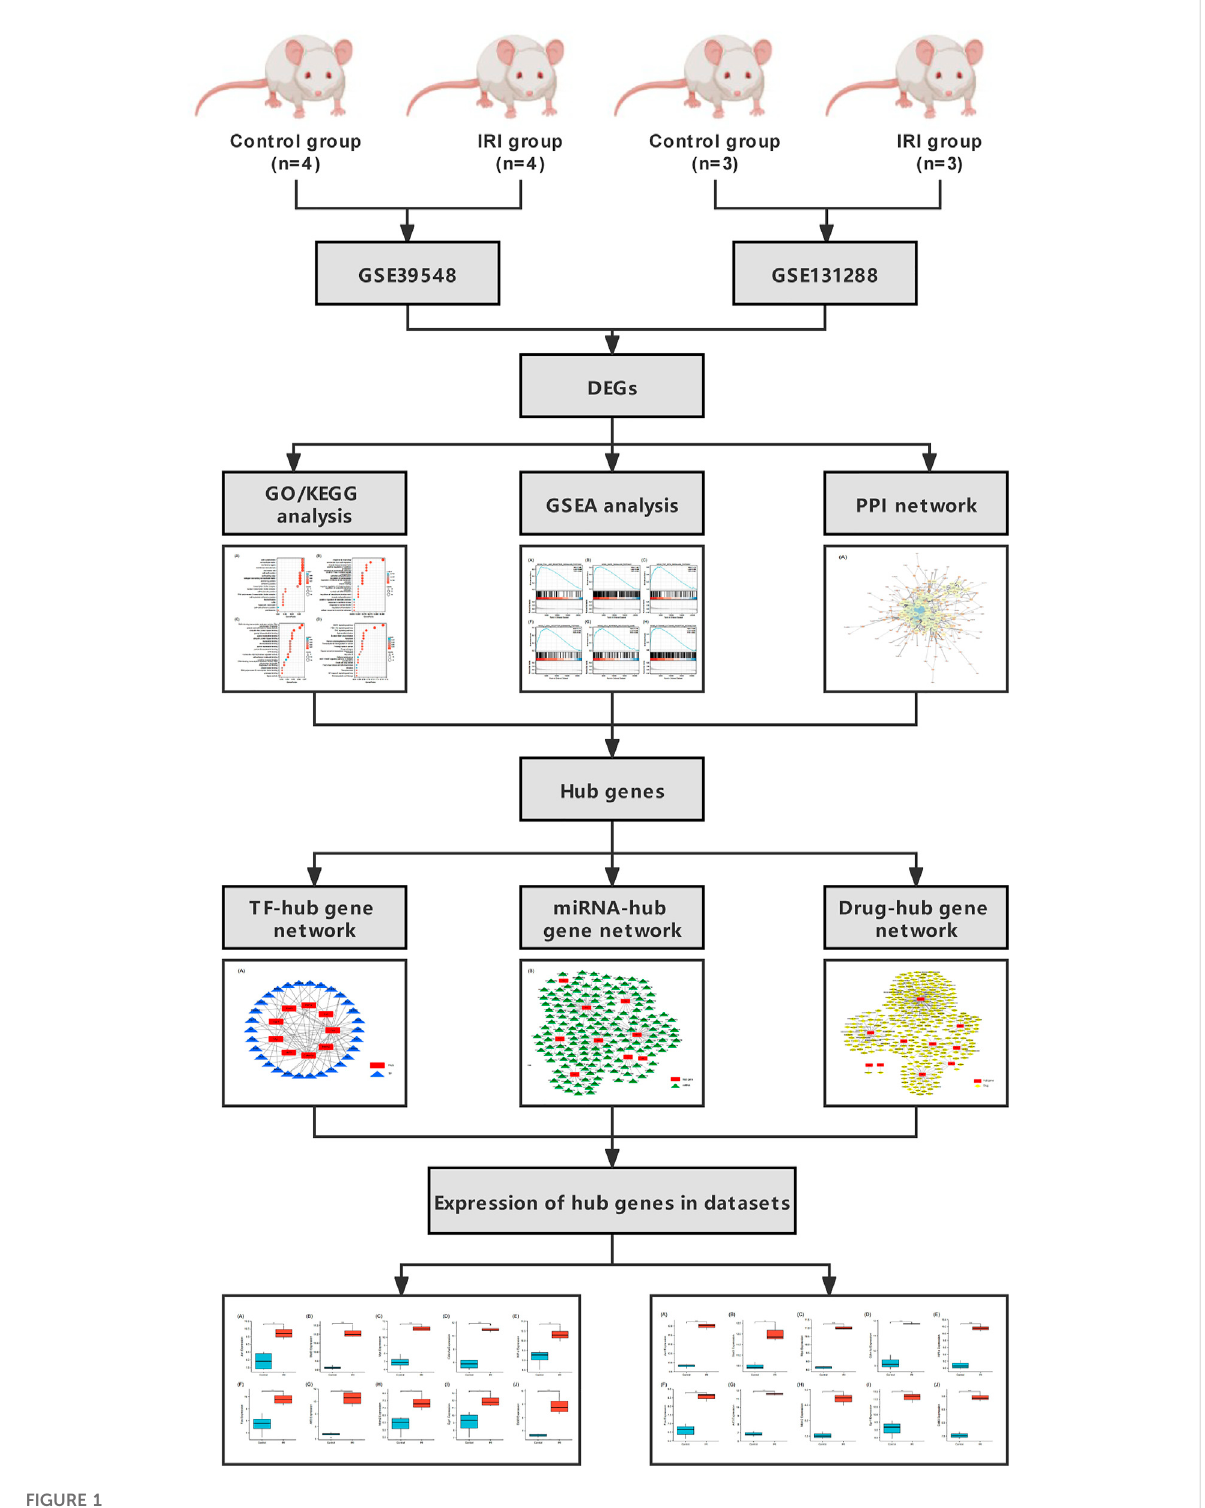
FIGURE 1 Flowchart of this